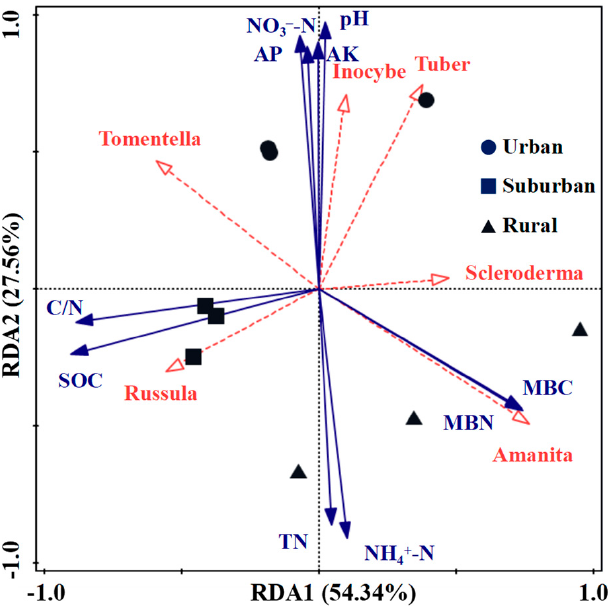
Figure 5. RDA of dominant ECM fungi and soil physicochemical properties in Quercus acutissima forests. The solid and dashed arrows represent ECM fungi and soil properties.